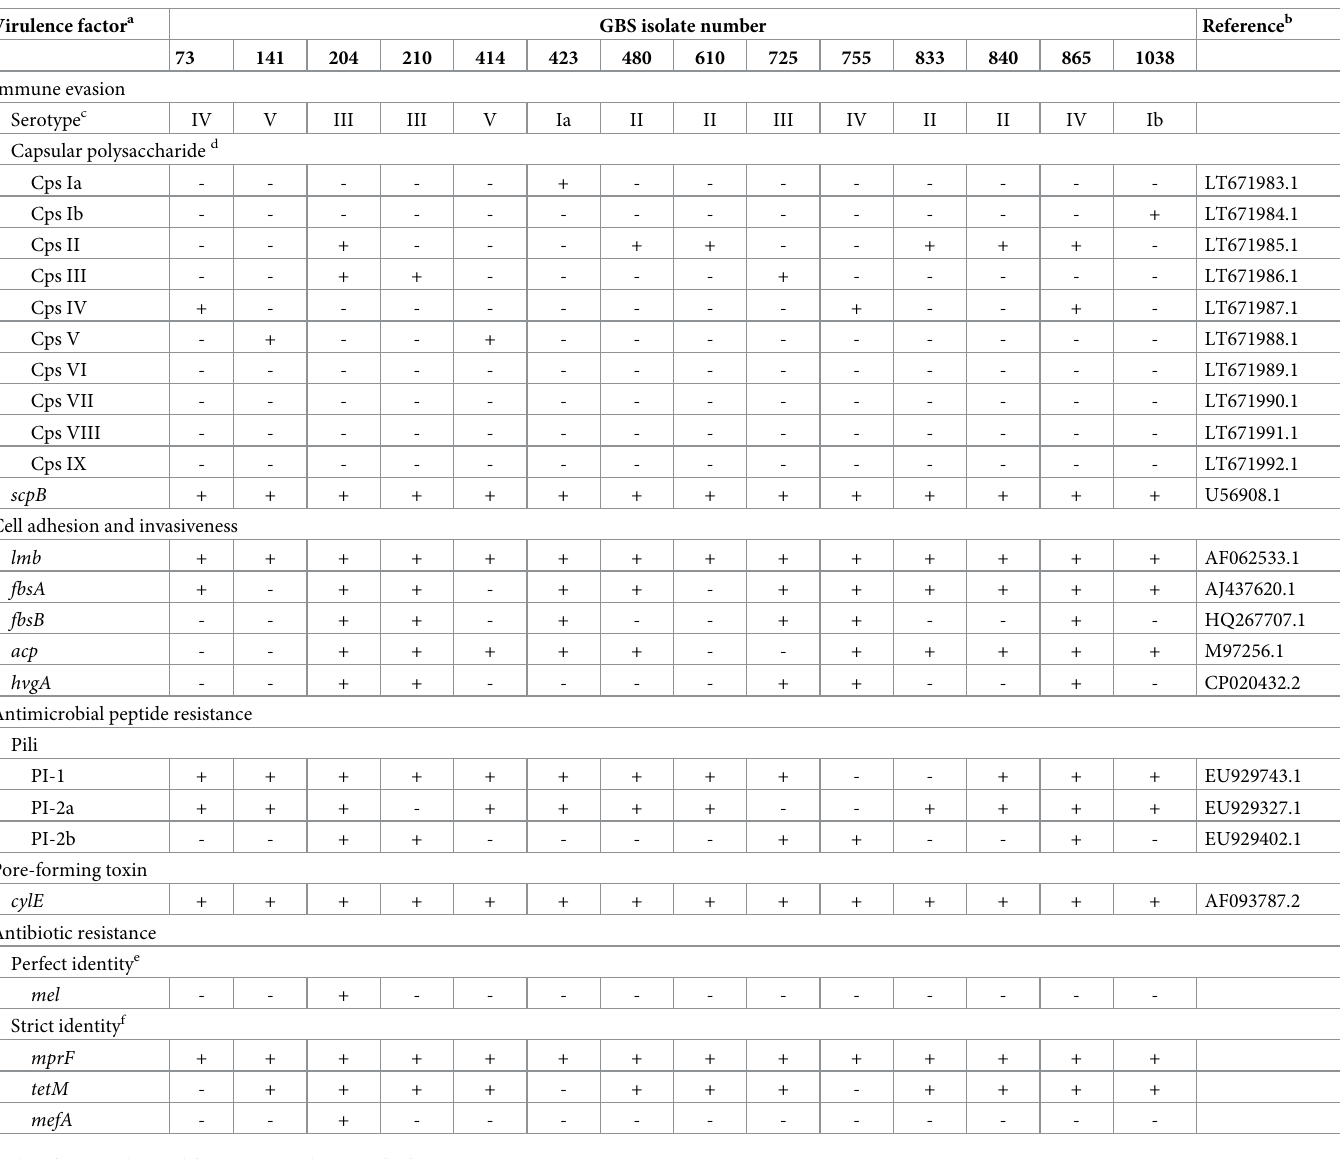
Table 6. Capsular polysaccharide (Cps), virulence factors, and antibiotic resistance genes in group B Streptococcus (GBS) isolated from pregnant women. Virulence factor